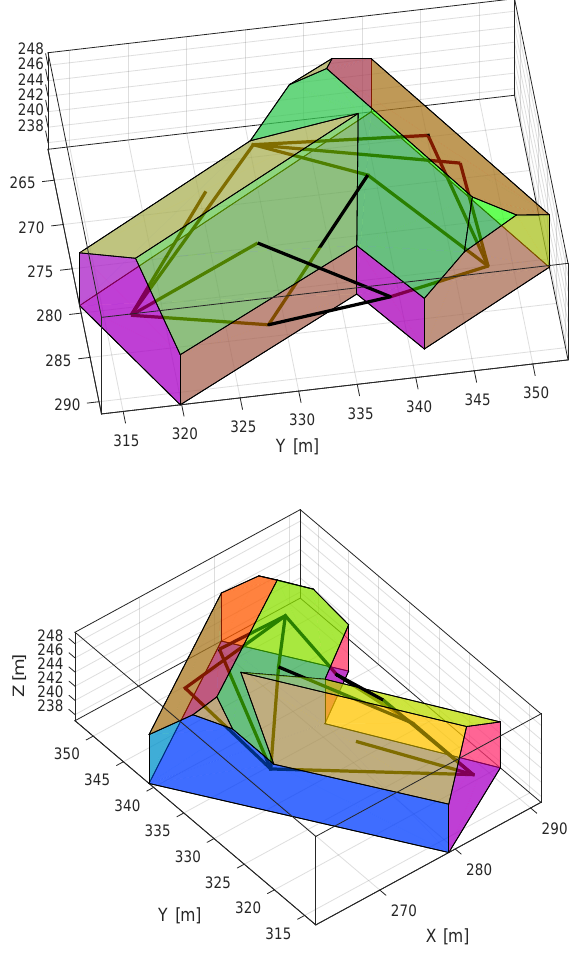
Figure 4. Two views of the boundary representation after merging adjacent faces with identical planes (13 faces). 20 orthogonality constraints have been